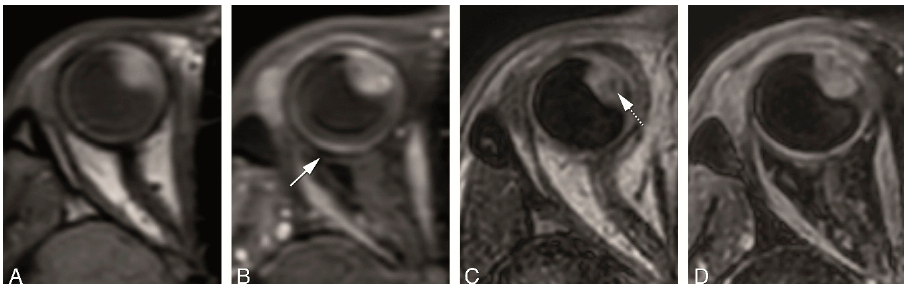
Figure 6. ( A – D ) 3D SE versus 3D GE sequences in two different patients. ( A – D ) 3D TSE 1 mm axial T1 ( A ), 3D TSE 1 mm enhanced axial T1 with fat signal suppression ( B ), 3D TFE 0.8 mm axial T1 ( C ) and 3D TFE 0.8 mm enhanced axial T1 with fat signal suppression ( D ), in a patient with a large uveal melanoma of the right eye. On one hand, on the SE sequences the outer limit of the sclera is better visualized (arrow), while on the GE sequences the outer limit of the sclera is more difficult to identify. On the other hand, the contrast resolution is better on the GE sequences, where a small area of necrosis is seen within the tumor (dashed arrow).